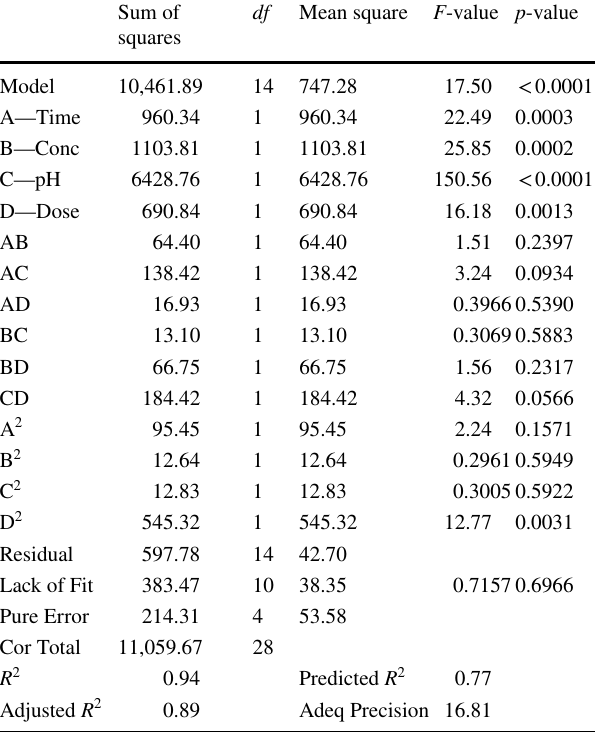
Table 5 Analysis of variance (ANOVA) for quadratic model of MG removal by Fe 3 O 4 /SC ncs